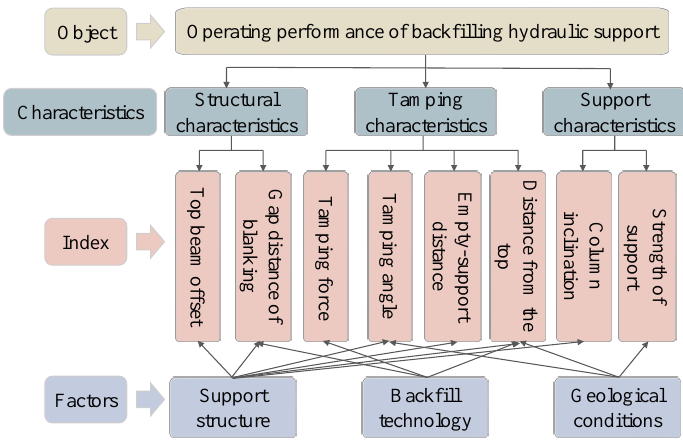
4 of 14 performances: the top beam offset, gap distance of blanking, tamping force, tamping an- gle, empty-support distance, distance from the top, column inclination, and strength of support. Figure 2 shows the various indices in detail. The eight operating performance indices include the effects of support structure, ge- ological conditions, and backfill technology on the supporting state of backfilling hydrau- lic supports [12]. To be specific, the support structure can affect the top beam offset, gap distance of blanking, tamping angle, empty support distance, distance from the top, and